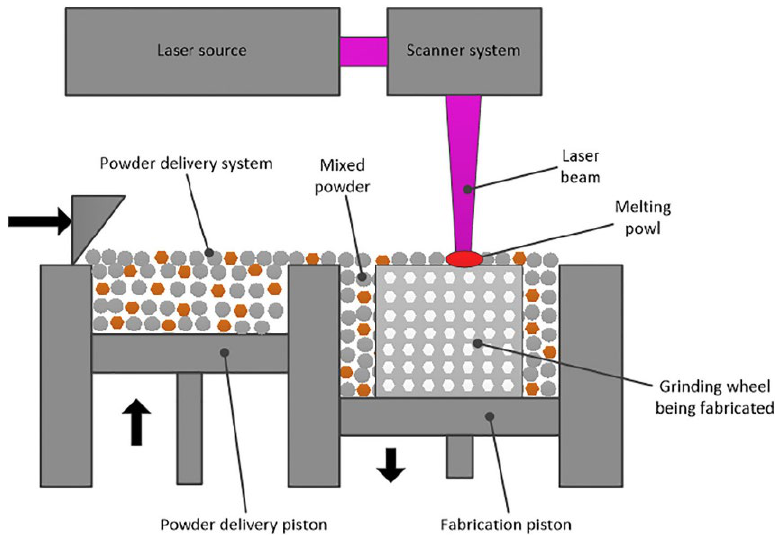
Figure 14. Principle of the SLM process [100].